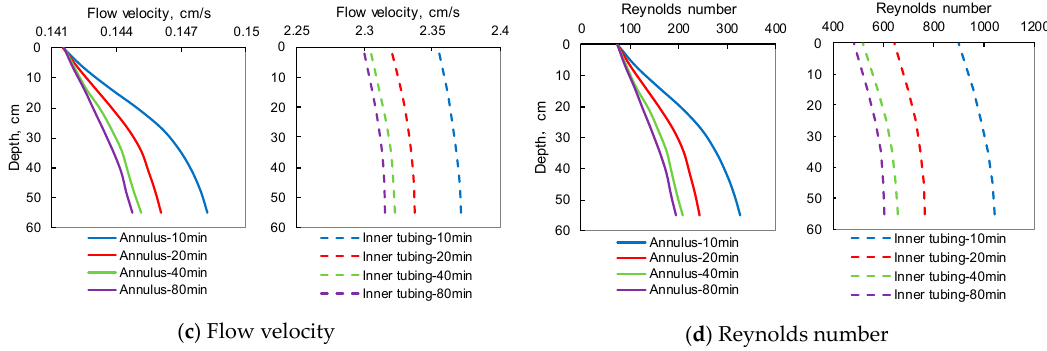
Figure 8. Thermo ‐ physical properties along the wellbore at different times.